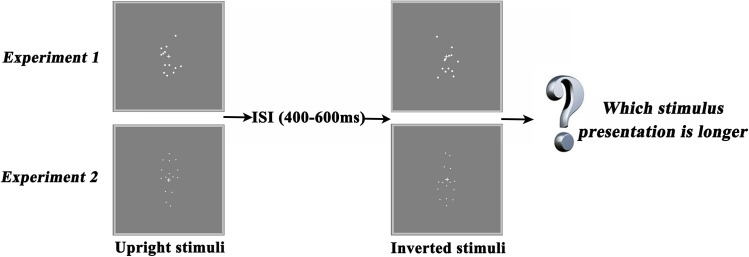
Task design.Experiment 1 employed scrambled biological motion (BM) sequences. Either an upright or an inverted scrambled BM stimulus was presented for an interval, followed by an interstimulus interval (ISI) and then the other stimulus. Experiment 2 employed canonical BM sequences. The presentation order of the two stimuli was randomized across trials.